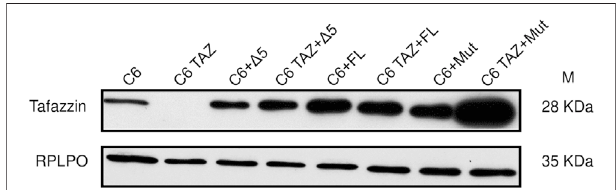
FIGURE 6 | Re-expression of human Δ 5, rat full length tafazzin (FL) and enzymatically dead mutant (Mut) in C6 and C6 TAZ knockout cells is